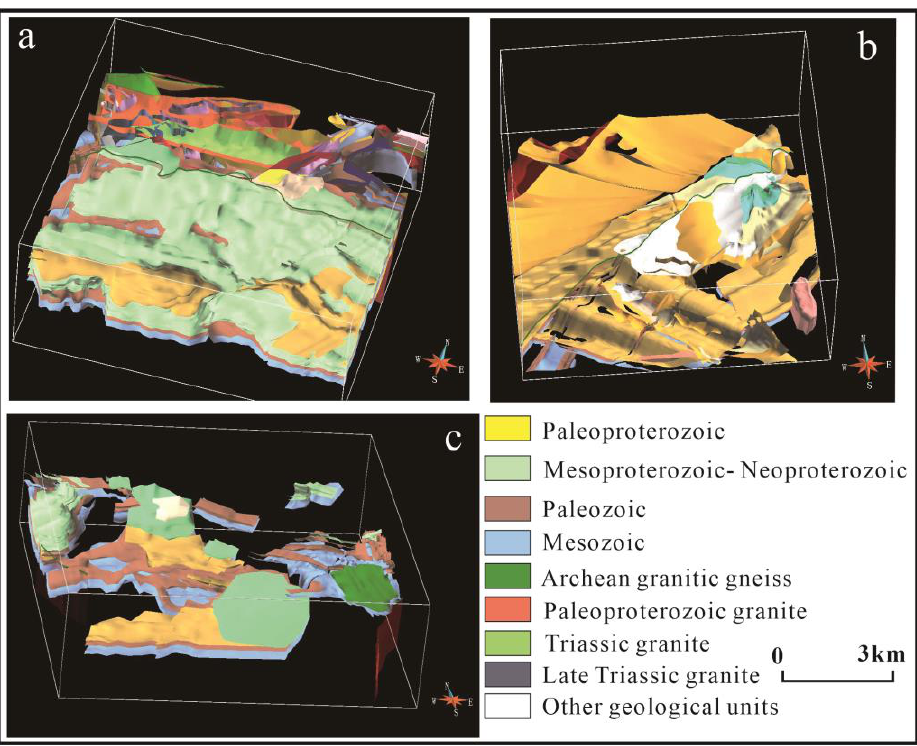
Figure 11. 3D geological models built from the generated sections. ( a ) Huanren area; ( b ) Shuangtaling area; ( c ) Yangjiabao area.